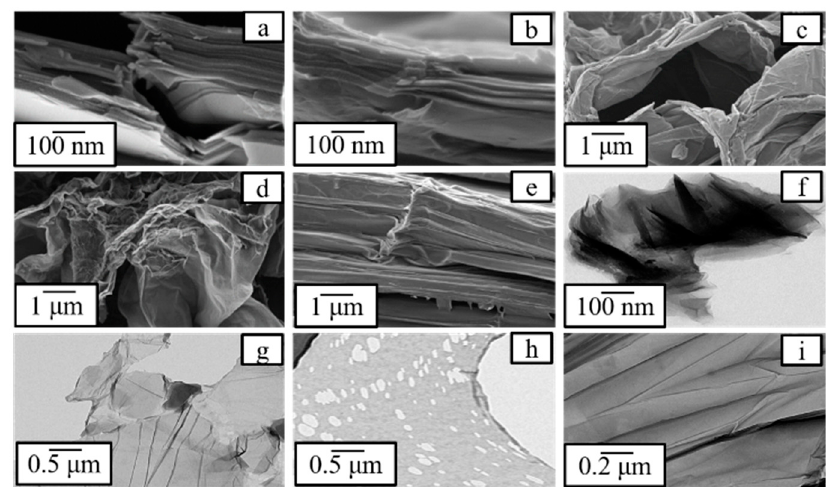
Figure 8. SEM ( a – e ) and TEM ( f – i ) images of graphene oxide and oxidative debris samples: ( a )—graphite, ( b )—GO, ( c )—bwGO, ( d )—rGO, ( e )—rbwGO, ( f) —bulk GO, ( g )—single layer GO, ( h )—oxidative debris, ( i )—stacked and wrinkled GO layers.